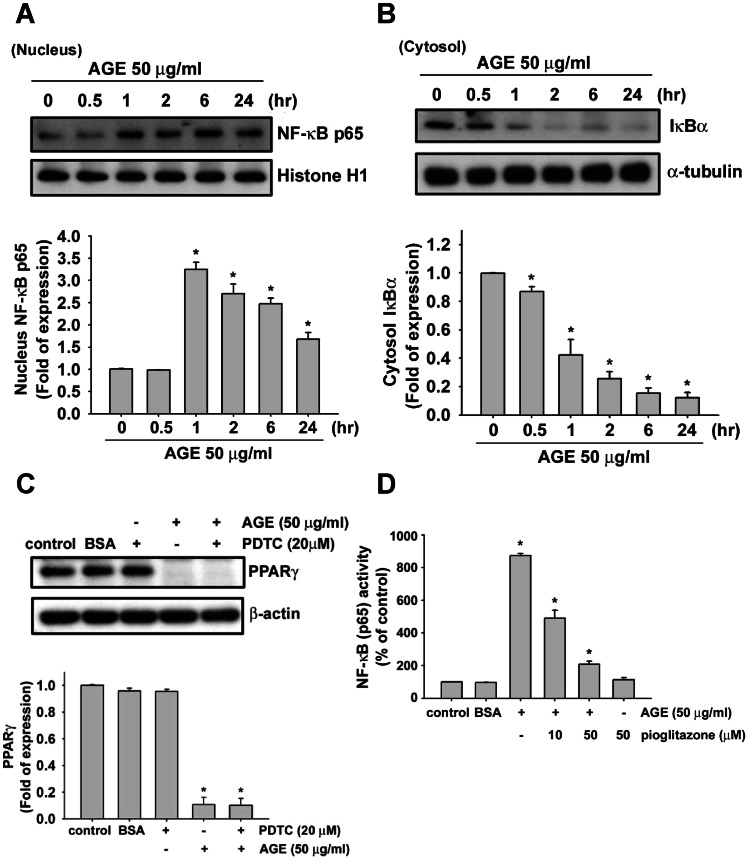
AGEs activate NF-κB activity in human OA chondrocytes, which can be reversed by pioglitazone.Human OA chondrocytes (1×106/ml) were incubated with AGEs (50 µg/ml) for indicated time intervals. The expressions of nuclear p65 (A) and cytosol IκBα degradation (B) were determined by Western blotting. In C, chondrocytes were pretreated with PDTC (20 µM) for 1 hour followed by treatment with AGEs for 2 hours. Protein expression of PPARγ was determined by Western blotting. Densitometric analysis for nuclear p65, cytosolic IκBα, and PPARγ levels corrected to Histone H1, α-tubulin, and β-actin, respectively, is shown. In D, chondrocytes (1×106/ml) were pretreated with pioglitazone (10 and 50 µg/ml) for 1 hour followed by stimulating with AGEs (50 µg/ml) for 24 hours. NF-κB activity was measured using NF-κB (p65) Transcription Assay kit and quantified with a spectrophotometric plate reader at wavelengths of 450 nm. All data are presented as mean ± SEM for three independent experiments. *: P<0.05 versus control. #: P<0.05 versus AGEs alone.